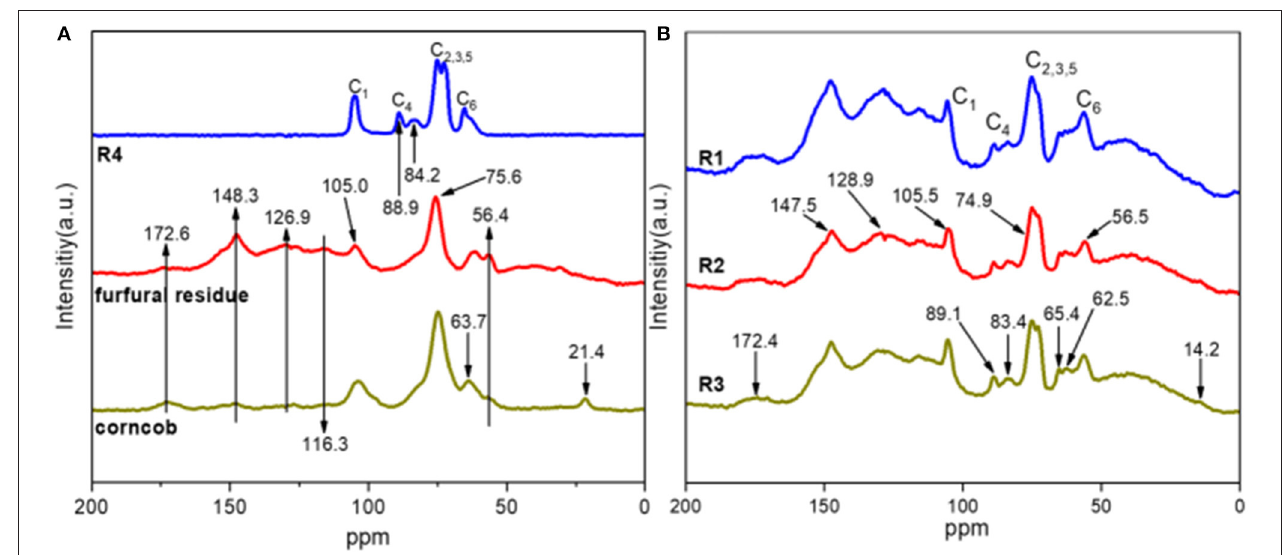
FIGURE 7 | 13 C CP/MAS NMR spectra of corncob, alkali treated corncob, original (A) , and alkali treated furfural residue (B) .